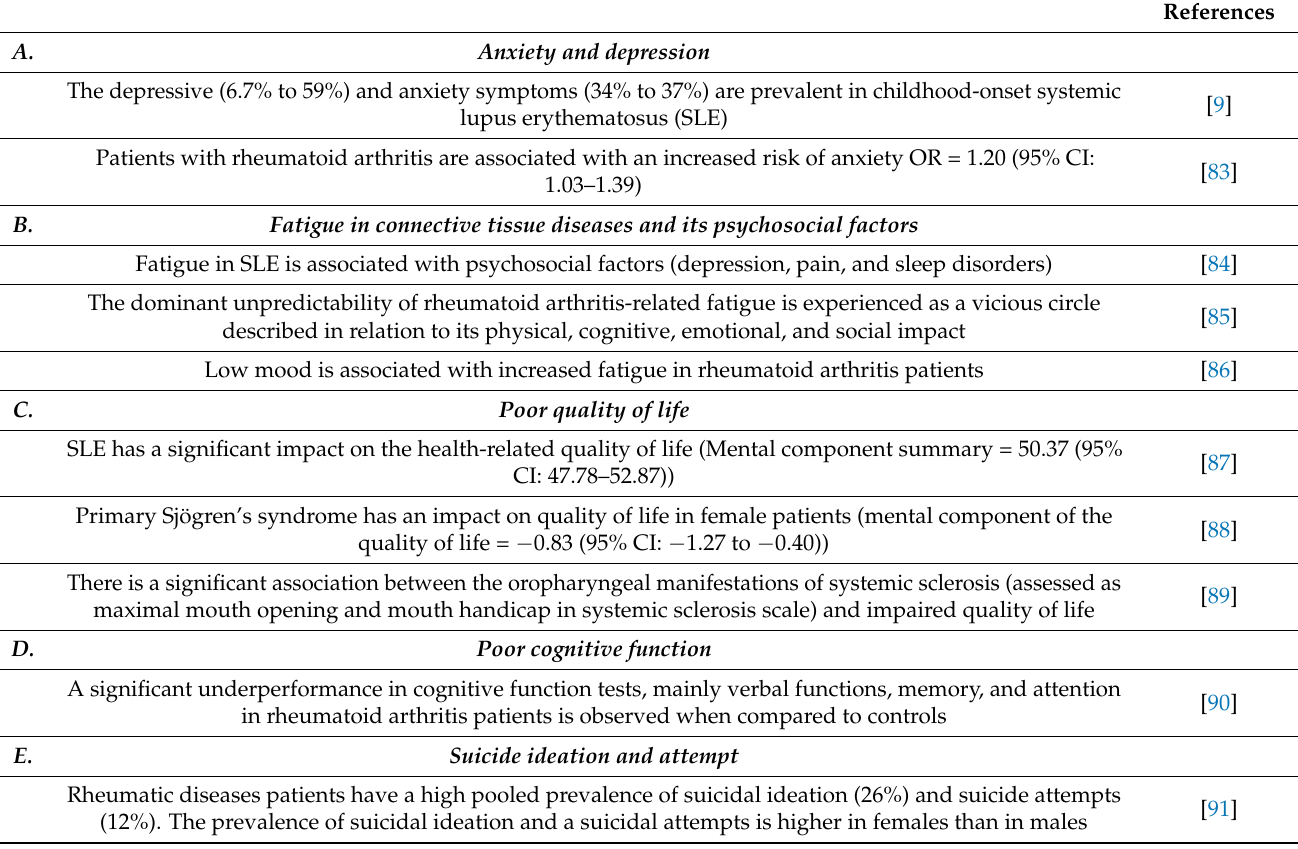
Table 4. Psychological backgrounds of patients with connective tissue